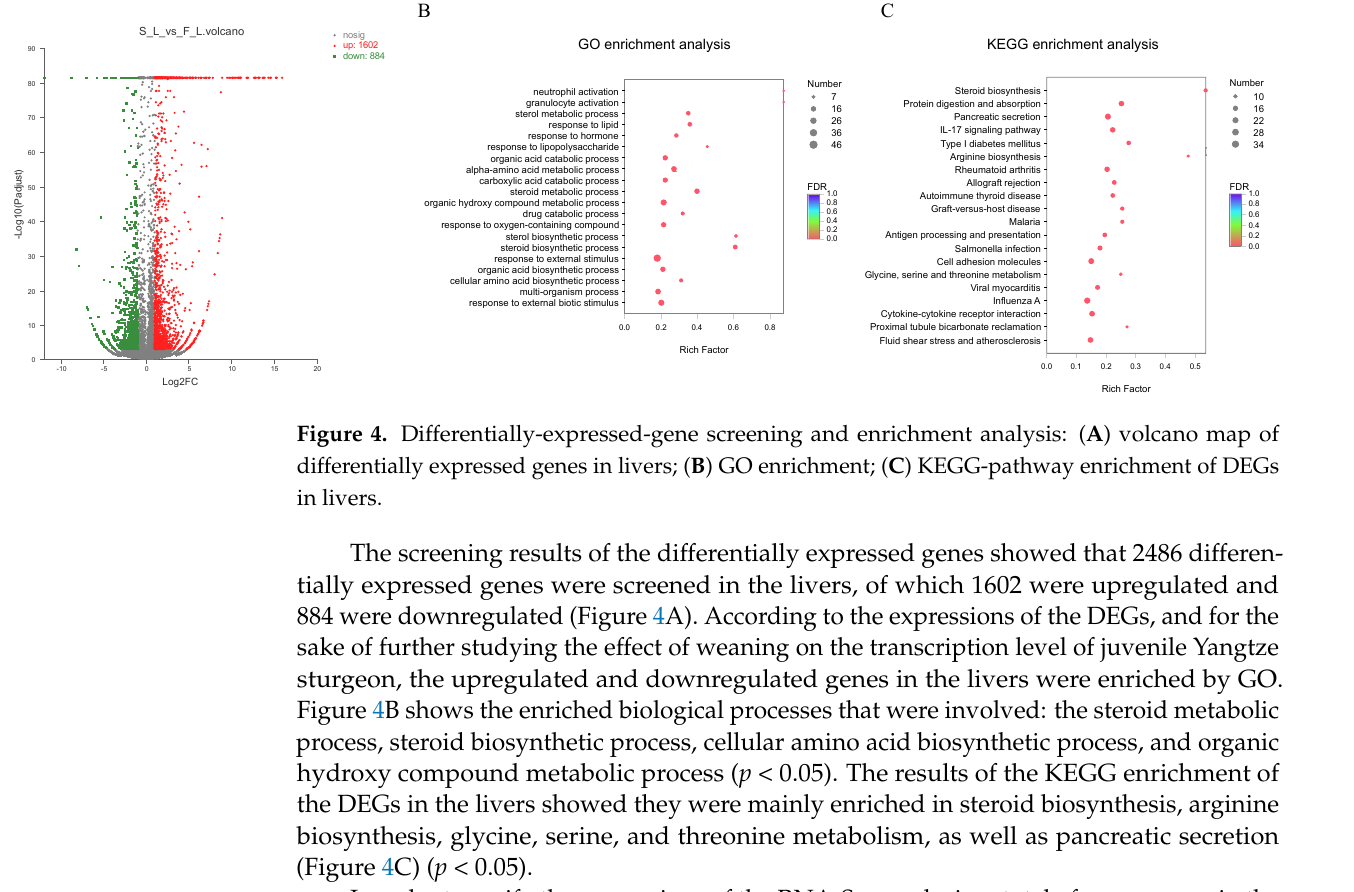
Figure 4. Differentially-expressed-gene screening and enrichment analysis: ( A ) volcano map of dif- ferentially expressed genes in livers; ( B ) GO enrichment; ( C ) KEGG-pathway enrichment of DEGs Figure 5. Part of DEGs were verified by RT-qPCR. Gene-expression levels were normalized to that in livers. of β -actin and EF1- α . Data are presented as the group means ± SD ( n = 5). Statistical comparison of the mRNA levels detected in different groups was carried out by t -test of variance (* p < 0.05, ** p < 0.01, *** p < 0.001). ( A ) RT-qPCR of liver; ( B ) RNA-Seq of liver.